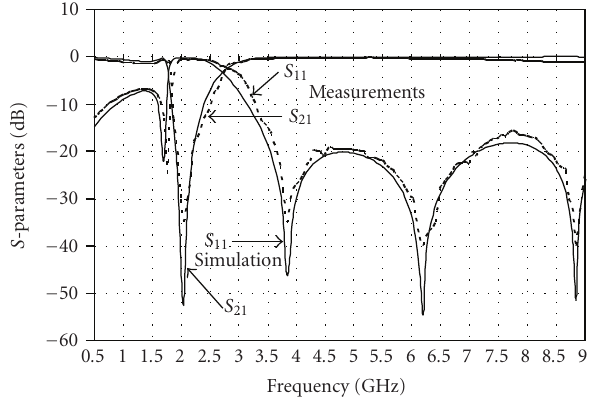
Figure 13: Simulation and measurement results of the shortened stepped impedance bandstop